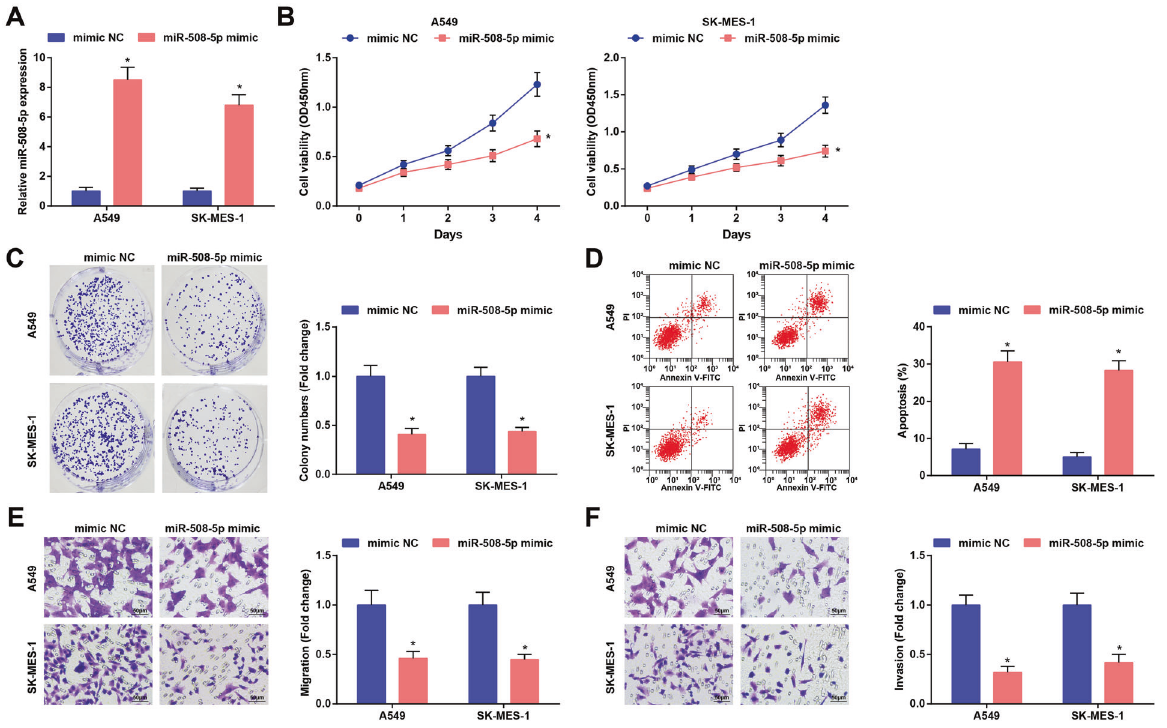
Fig. 4 Elevated miR-508-5p restricts malignant behaviors of LC cells. A miR-508-5p expression in LC cells was determined using RT-qPCR. B Cell viability was assessed using CCK-8 assay. C Colony formation ability of cells was detected using cell colony formation assay. D Apoptosis of cells was assessed using fl ow cytometry. E and F Migration and invasion of cells were detected using Transwell assay; * P < 0.05 vs. the mimic NC 5p/CRISP3 axis in LC, and our results indicated that LINC01342 promoted the malignant behaviors of LC cells through regulating miR-508-5p/CRISP3, thus contributing to LC progression. To begin with, we detected the expression of LINC01342 expression in tissues and cells and found that it was upregulated in LC tissues and cells, respectively, compared with adjacent